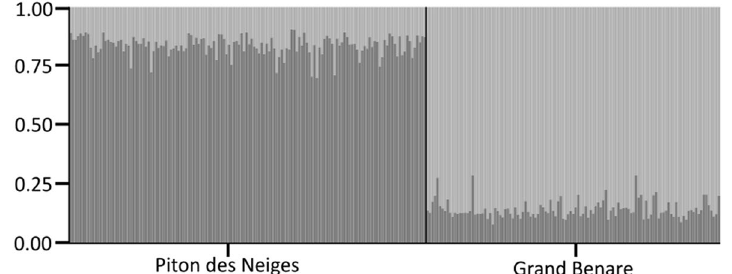
Figure 3. Membership coefficients assigned to 259 individual Barau’s Petrels, sampled at two breeding colonies, based on a Bayesian clustering analysis performed using an Admixture Model assuming K = 2 and using sampling location as a-priori information. Colors within each bar represent the two genetic clusters. Membership coefficients assigned to all individual Barau’s Petrels for the two genetic clusters. Vertical bars represent individuals and colors correspond to the two genetic clusters.